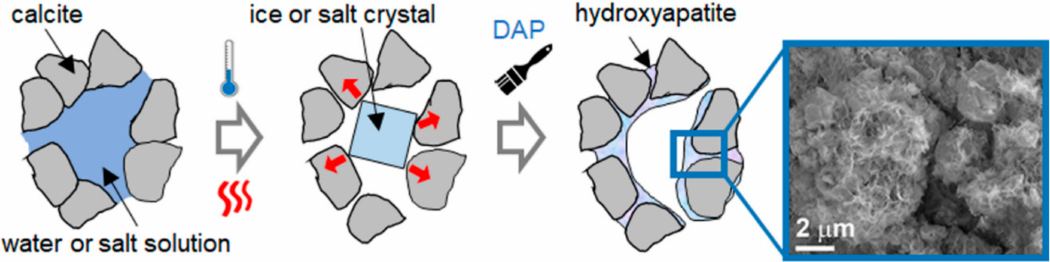
Figure 7. Scheme illustrating the consolidating action of the phosphate treatment, with an example of a SEM image showing newly formed HAP bonding calcite grains in